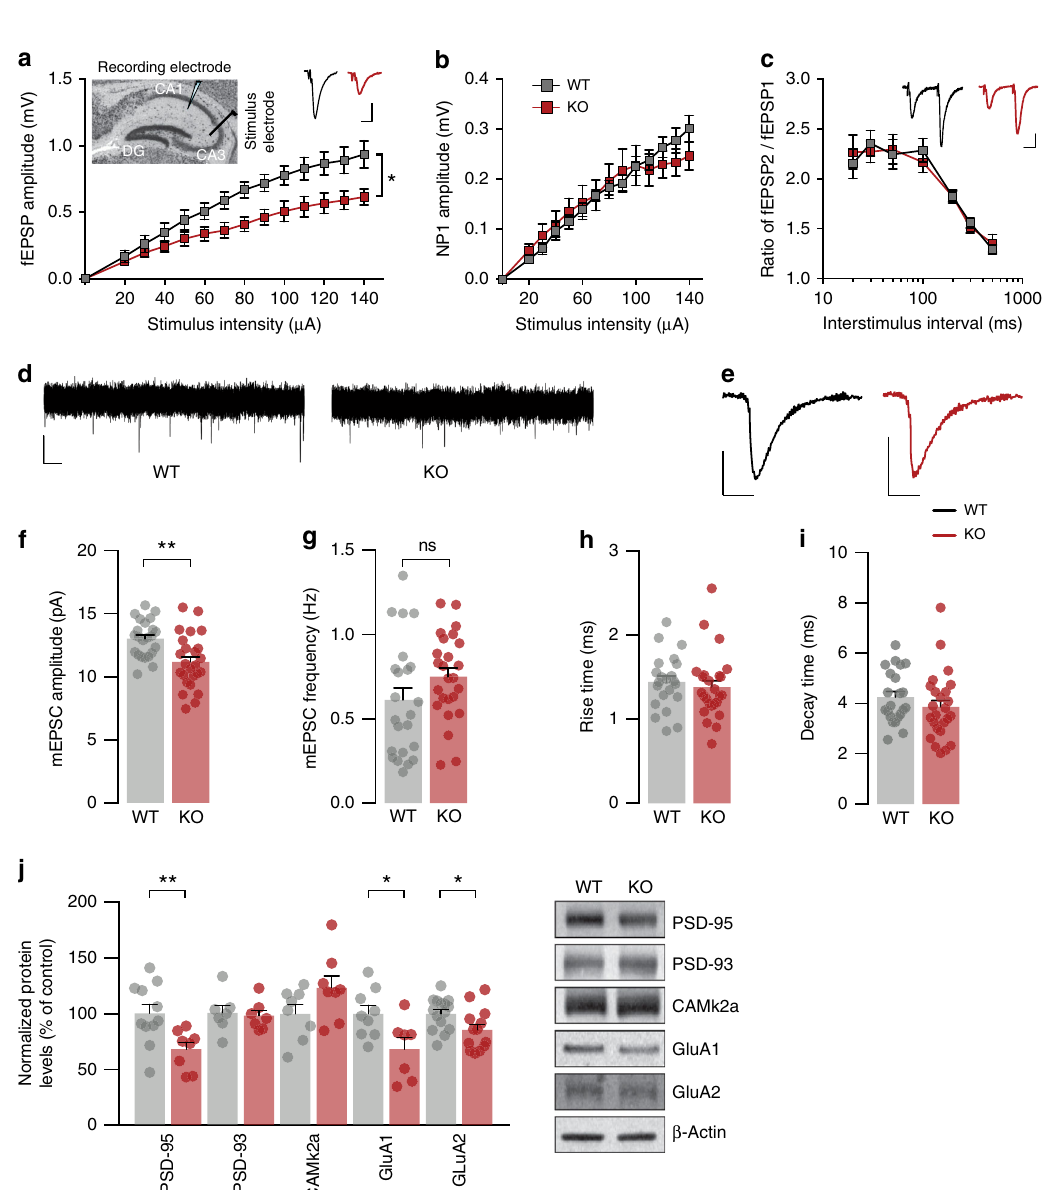
Fig. 2 Deletion of Gprasp2 impairs glutamatergic transmission. a Input – output curve shows fEPSPs are reduced in the hippocampus of Gprasp2 − /y ; WT n = 7/3 slice/mice, KO n = 5/3 slices/mice; two-way repeated measures ANOVA. Inset, representative traces. Scale bar, 0.5 mV, 10 ms. b NP1 amplitude is unaltered between KO and WT littermates; WT n = 7/3 slices/mice, KO n = 5/3 slices/mice. c Paired-pulse facilitation is not altered in Gprasp2 KO mice; WT n = 11/7 slices/mice, KO n = 7/7 slices/mice. Inset shows representative traces. Scale bar, 0.5 mV, 10 ms. d mEPSC traces from Gprasp2 − /y and WT littermates. Scale bar, 10 pA, 1 s. e Representative mEPSC average traces. Scale bar, 5 pA, 10 ms. f , g Reduced mEPSC amplitude ( f ) but not frequency ( g ) in Gprasp2 − /y CA1 pyramidal neurons; WT n = 23/4 cells/mice, KO n = 25/4 cells/mice; two-tailed unpaired t- test. h , i Rise ( h ) and decay ( i ) times for mEPSCs is unchanged in Gprasp2 − /y and WT mice; WT n = 22/4, KO n = 25/4; two-tailed Mann – Whitney test. j Reduced levels of AMPA receptors and PSD-95 in hippocampal synaptosomal plasma membrane fraction in Gprasp2 − /y mice; WT n = 7 – 15, KO = 7 – 13; two-tailed unpaired t -test. Data are presented as means ± s.e.m. Statistical signi fi cance: * p < 0.05, ** p <